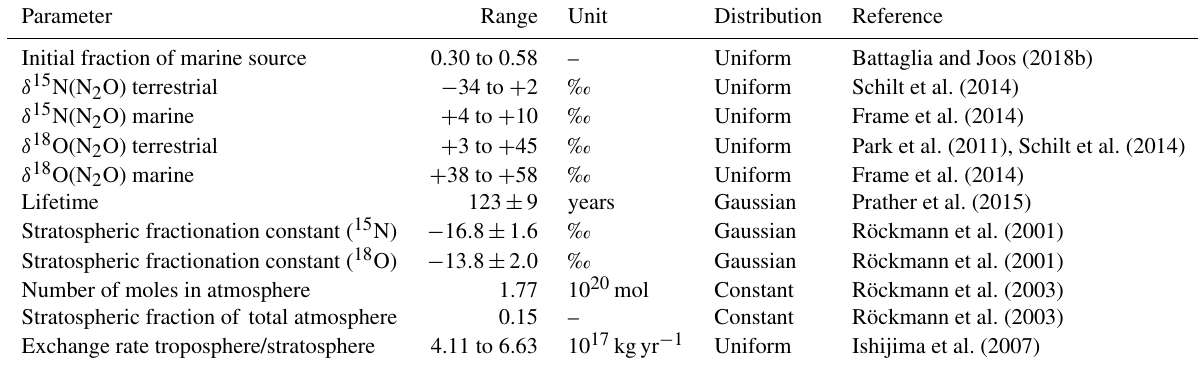
Table 2. Parameter ranges used in the atmospheric two-box model for the calculation of terrestrial and marine N 2 O emissions.